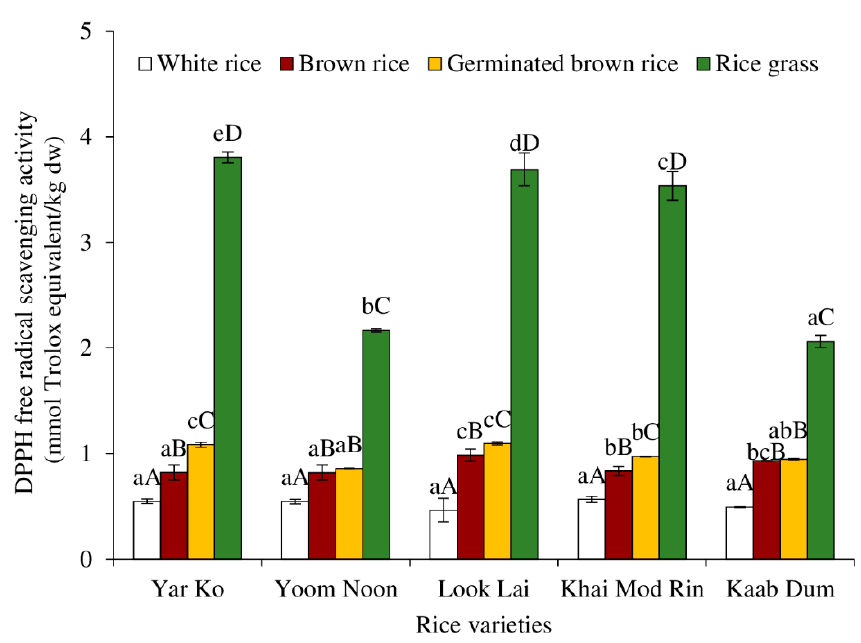
Figure 6. Effect of rice variety and processing condition on DPPH free radical scavenging activity of aqueous extract of Thai indigenous rice. Bars represent the standard deviations from triplicate determinations. Different lowercase letters within the same processing condition indicate significant differences ( p ˂ 0.05). Different uppercase letters within the same variety indicate significant differences ( p ˂ 0.05).